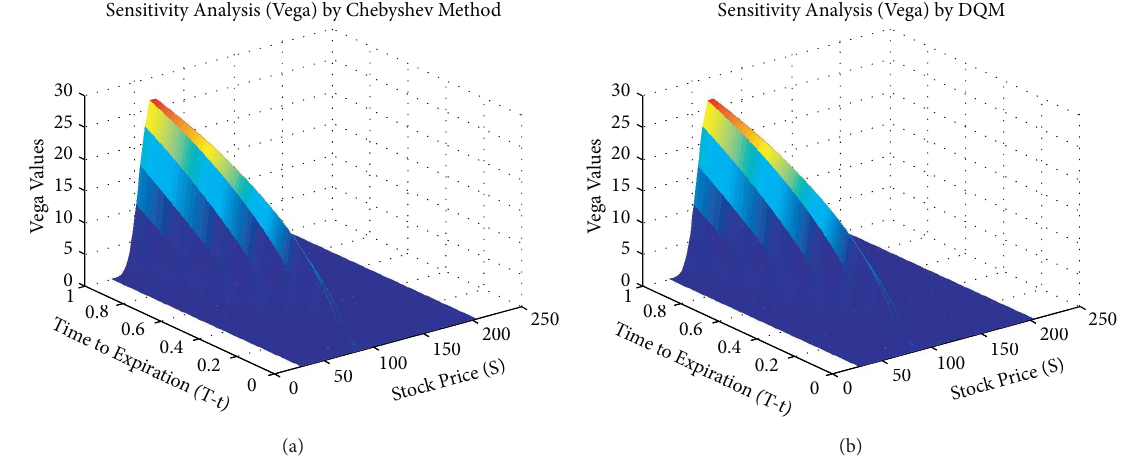
Figure 19: Sensitivity analysis (vega) by Chebyshev spectral method (a) and by differential quadrature method (b).